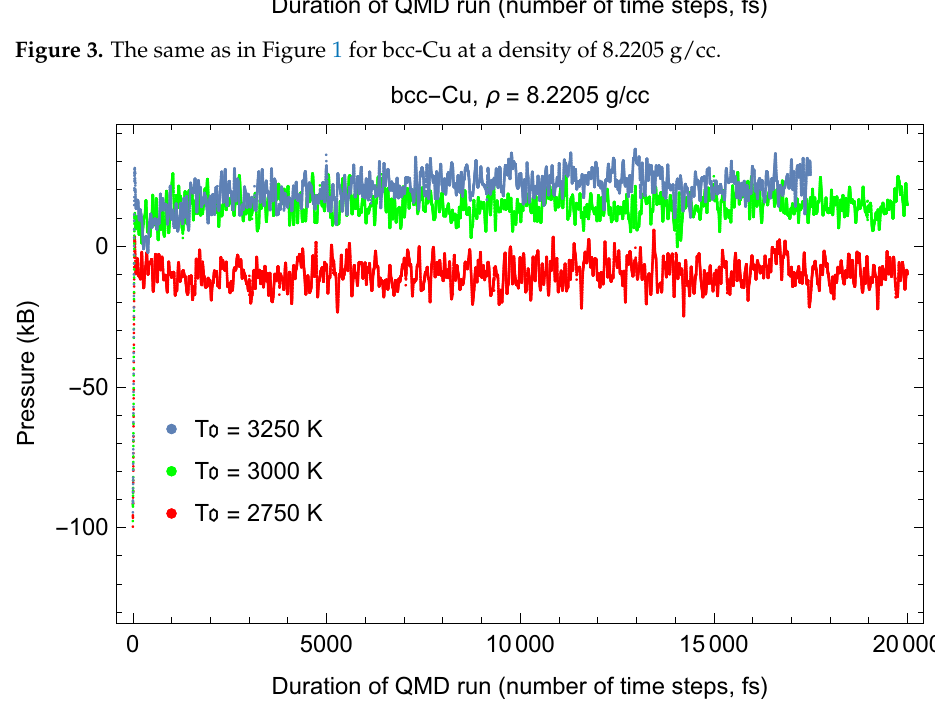
Figure 4. The same as in Figure 3 for melting P